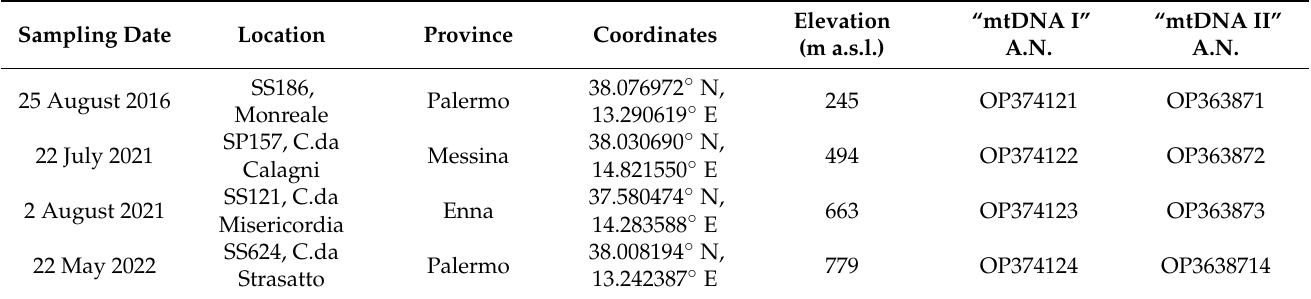
Table 1. Origin and GenBank accession numbers (A.N.) of the analysed Sicilian Martes martes specimens. Geographical coordinates are expressed in terms of decimal degrees (Map Datum: